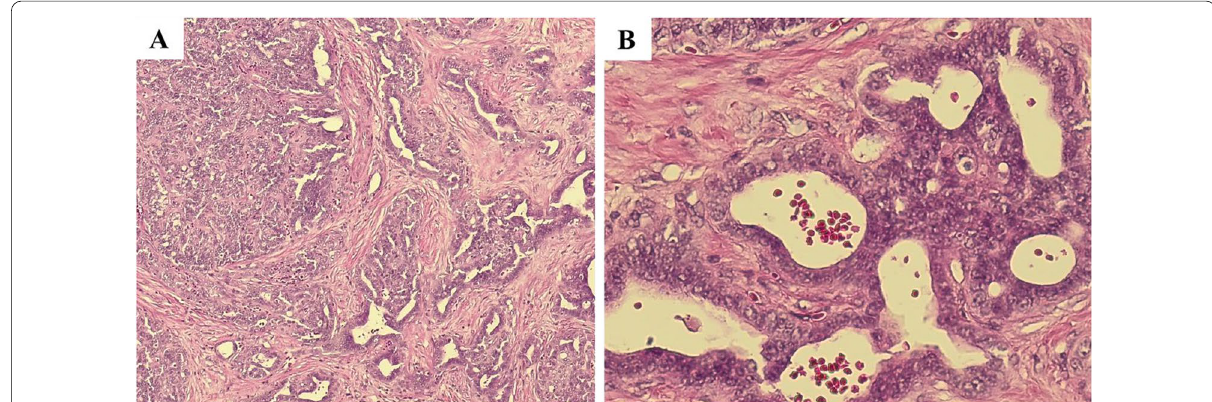
Fig. 5 Microscopic findings with hematoxylin and eosin staining. A , B Atypical, poorly formed, cuboidal epithelium at the margins formed by large and small dilated tubular glands, suggesting a cholangioma-like morphology ( A